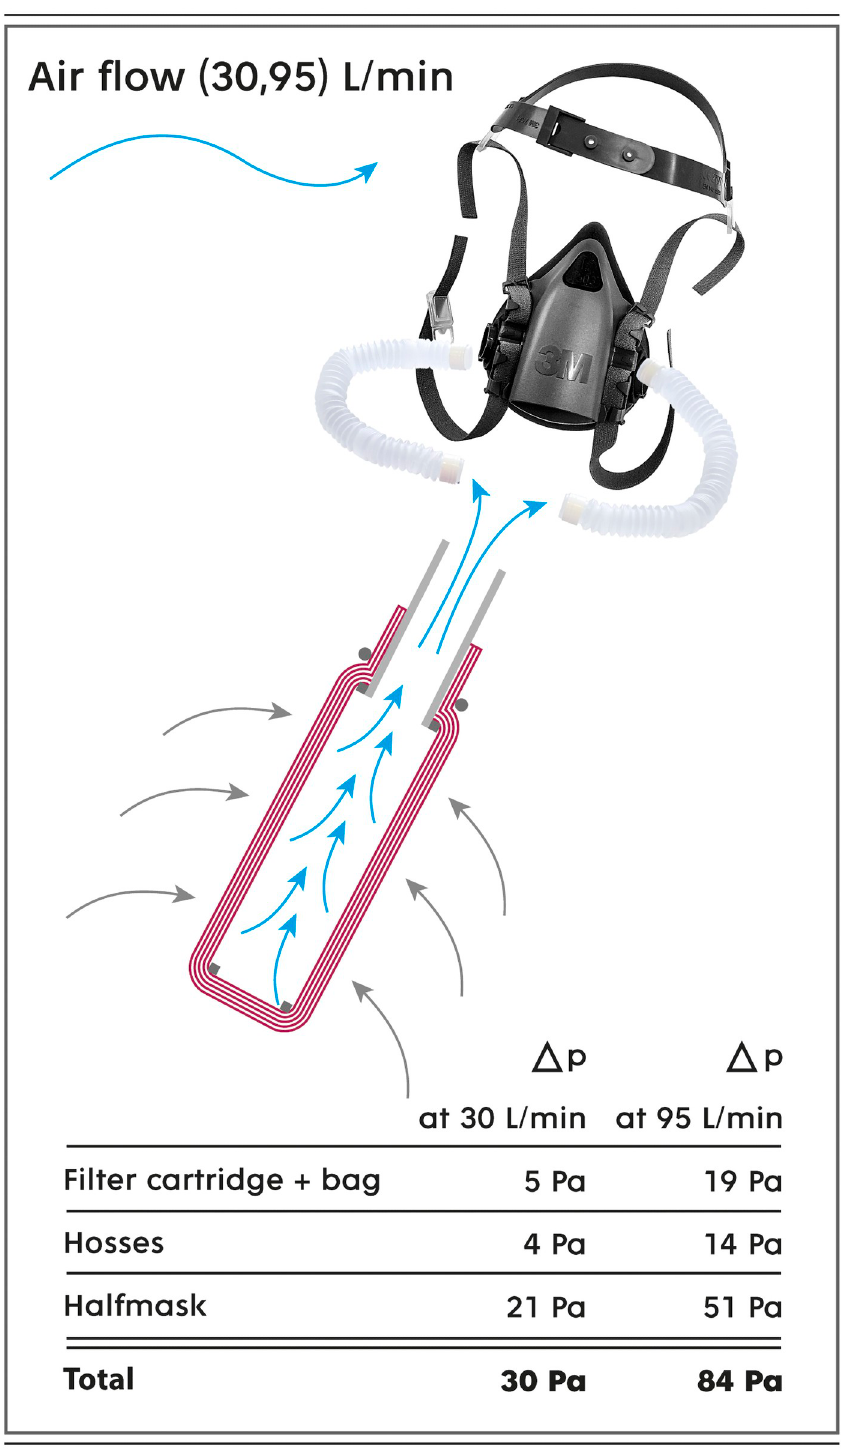
Fig 4. Pressure drop of the filter kit and its components. Shown are the pressure drop of the filter kit and its components at volumetric flow rates of 30 and 95 L/min, which correspond to air inhalation during light and heavy physical exercise, respectively. The cross-section of the filter cartridge is shown. The carrier (backpack) is not shown even though its pressure drop is taken into account.